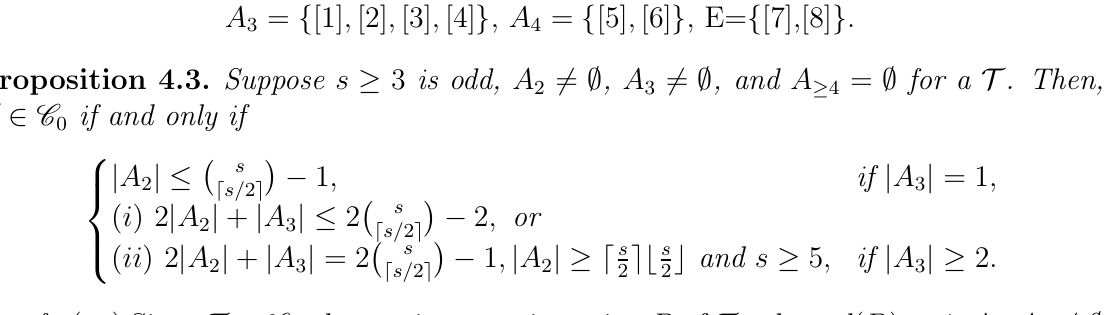
Figure 9: Orientation D for H for s =